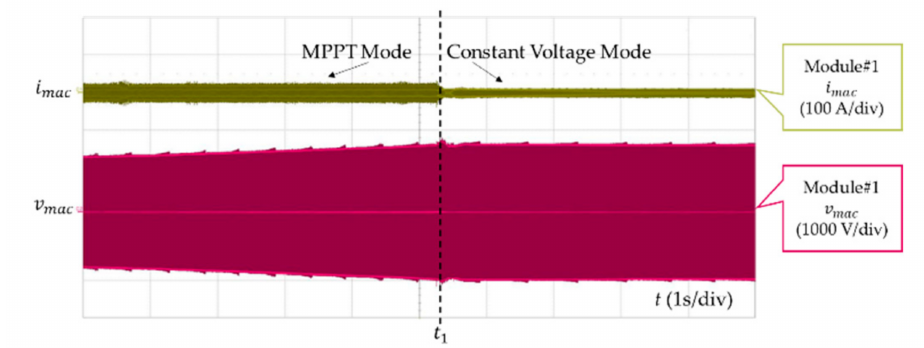
Figure 30. The module waveform of mode